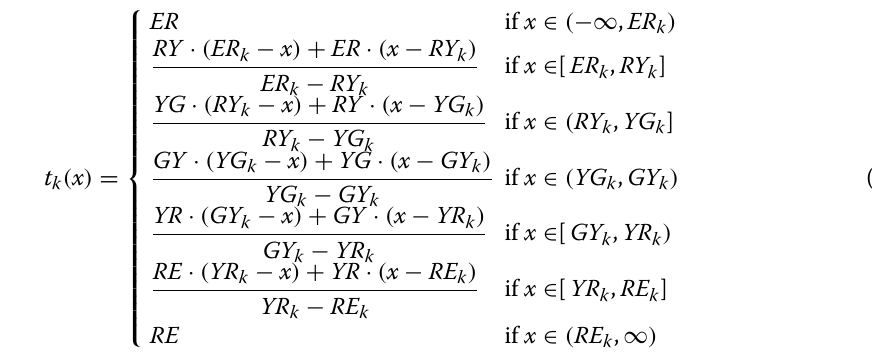
For simplicity we use the piece-wise linear interpolation function Eq. 4, which pre- serves the order of the KPI values and maps the range of different KPI classes to the same smaller range of [ − 1, 1]. The piece-wise nature allows weighting and shifting of the range of individual KPI